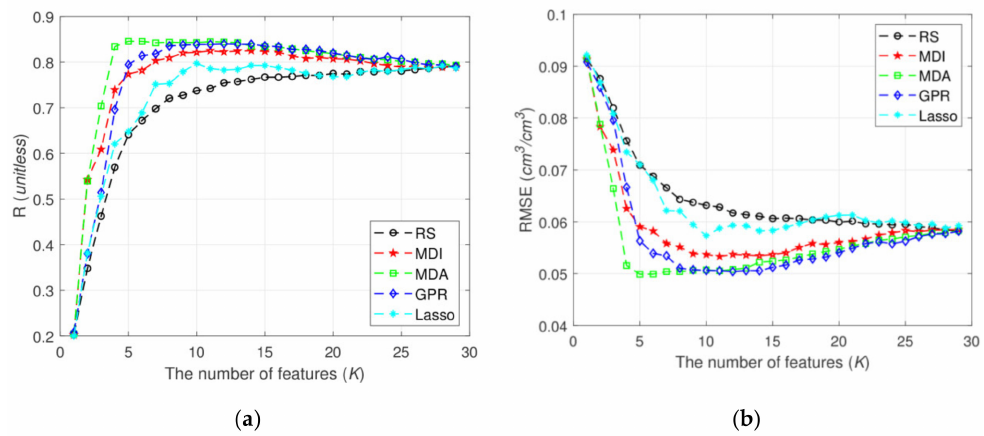
Figure 5. ( a ) R and ( b ) RMSE based on different embedded type feature selection methods as a function of the number of